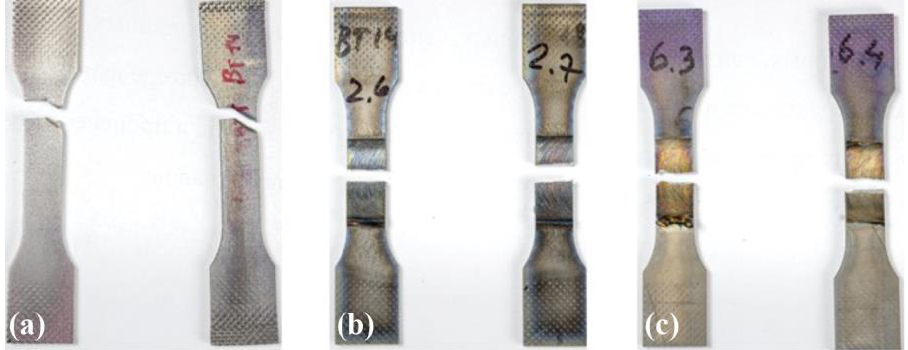
Figure 13. Specimens of base metal ( a ), Ti-4Al-3Mo-1V alloy FSW joints ( b ), and Ti-4Al-3Mo-1V/Ti- 6Al-4V alloy FSW joints ( c ) after fatigue testing.